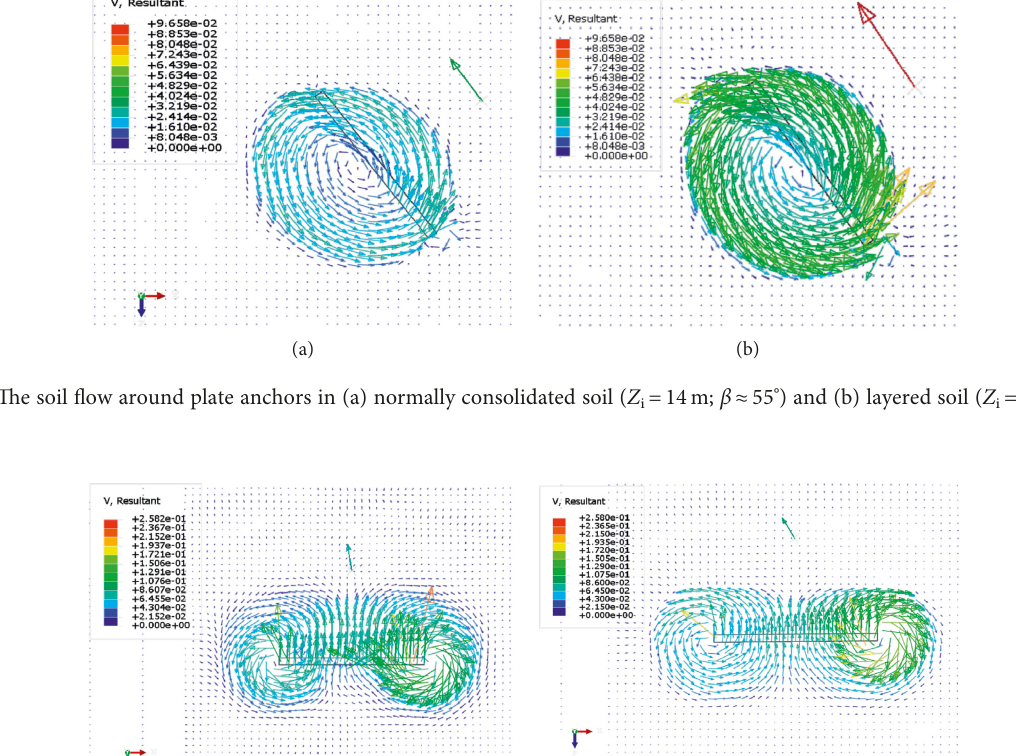
� 28m) and (b) layered soils ( Z i